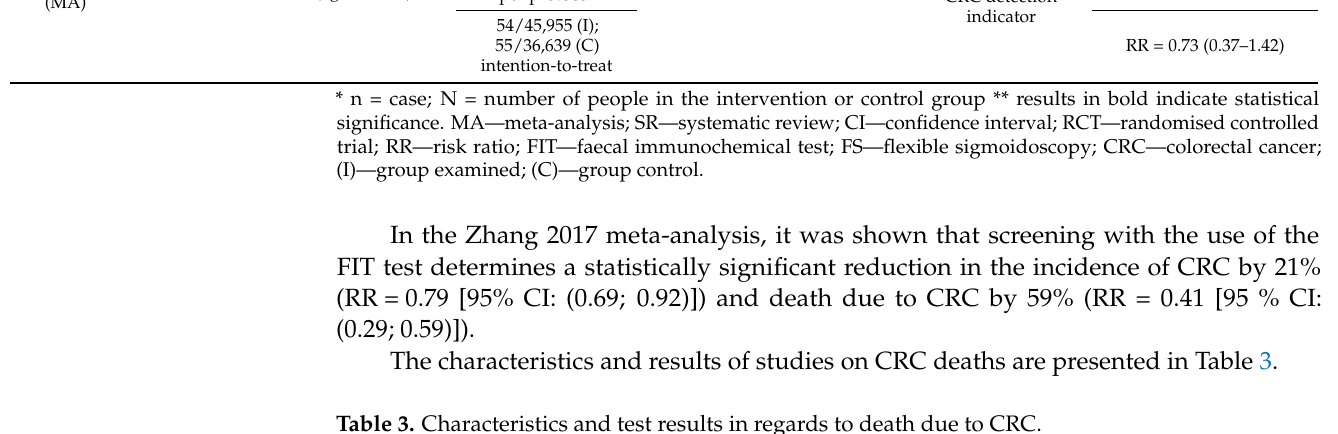
Table 3. Characteristics and test results in regards to death due to